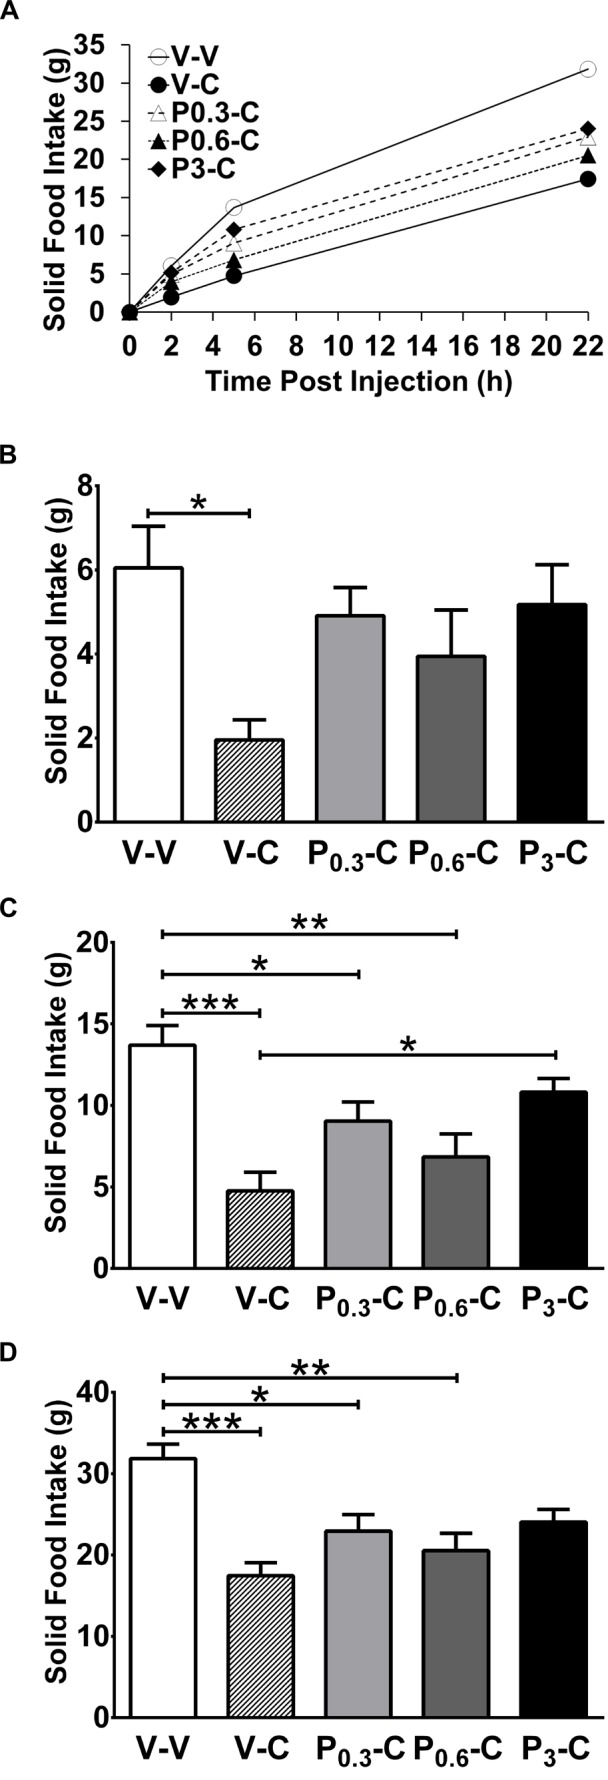
Fourth i.c.v. PACAP 6-38 blocks CARTp-induced reductions in solid food intake.Male Sprague-Dawley rats (n = 8) were pretreated with varying doses of PACAP fragment 6-38 (range 0.3–3 nmol) or vehicle prior to dosing with 0.3 nmol CARTp or vehicle. (A) Solid food intake measures (mean g ±SE) from the entire 22 h observation period. Cumulative solid food intake was recorded at 2 h (B), 5 h (C), and 22 h (D) following peptide injections and food presentation. CARTp significantly inhibited food intake 2–22 h after injection (Fig. 1A–D). Pretreatment with 3 nmol PACAP 6-38 completely blocked the effect after 5 h (Fig. 1 C). Significances from Tukey’s post hoc test after repeated measures ANOVA are indicated above: *p<0.05; **p<0.01; ***p<0.001. The treatment abbreviations are V = saline vehicle; C = 0.3 nmol CARTp; P0.3 = 0.3 nmol PACAP 6-38; P0.6 = 0.6 nmol PACAP 6-38; P3 = 3 nmol PACAP 6-38.